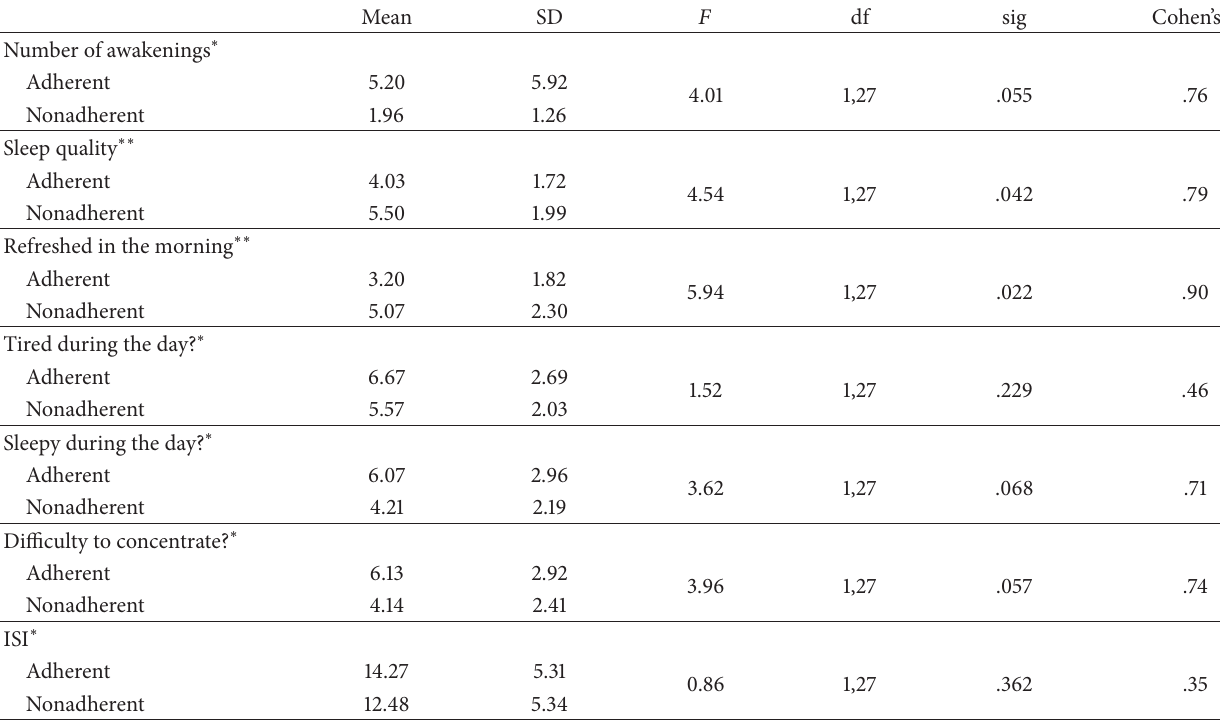
∗ Higher scores indicate worse functioning. ∗∗